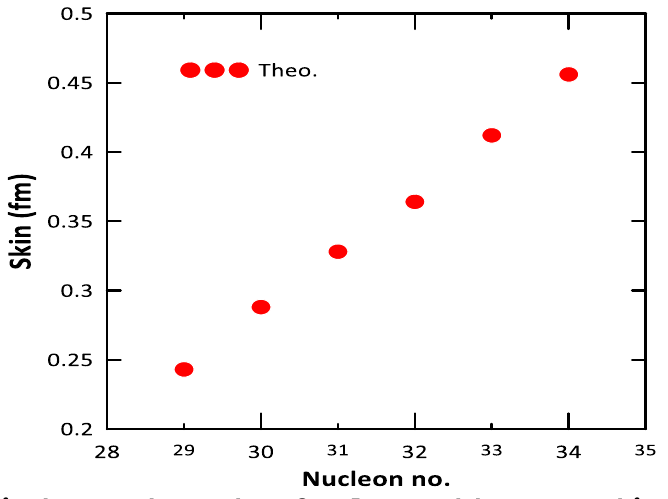
Fig. 2: Relation between the number of nucleons and the neutron skin thickness for 29-34 Mg nuclei. Table 2: The values of the neutron skin thickness for 29-34 Mg nuclei. Nuclei Skin(fm) 29 Mg 0.243 30 Mg 0.288 31 Mg 0.328 32 Mg 0.364 33 Mg 0.412 34 Mg 0.456